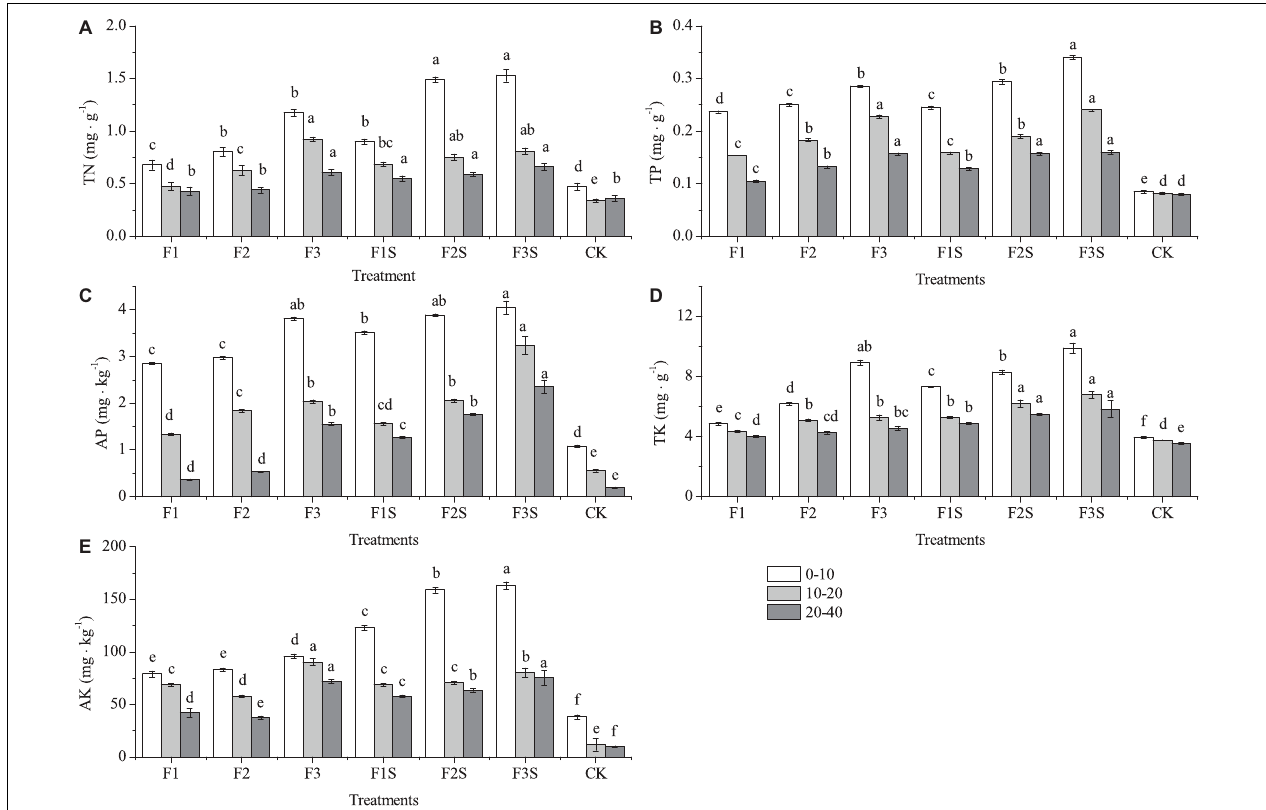
FIGURE 4 | The content of total nitrogen (TN) (A) , total phosphorus (TP) (B) , available phosphorus (AP) (C) , total potassium (TK) (D) , and available potassium (AK) (E) characteristics in the soil for different fertilization treatments. Different letters indicate significant differences among treatments (Tukey’s test, P ≤ 0.05).